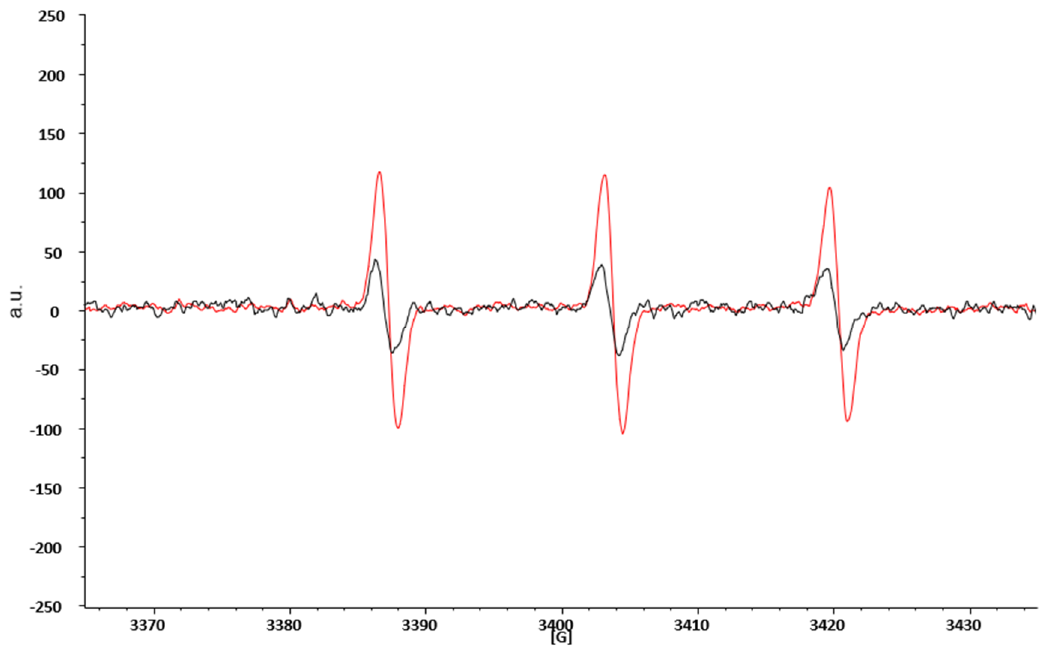
Figure 2. EPR spectroscopic spectra of CP • obtained from blood analyses of HD and obese patients